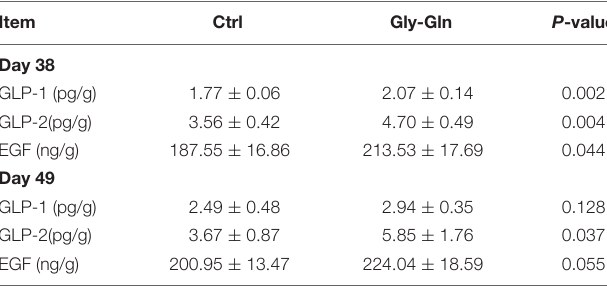
TABLE 2 | The concentrations of endocrine peptides in ileal mucosa of piglets on the day 38 and day 49.